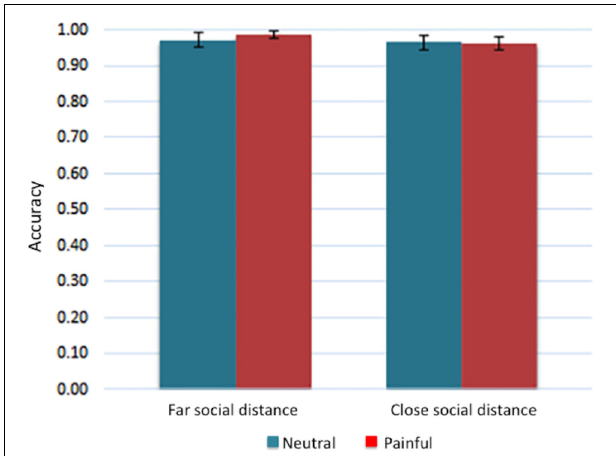
FIGURE 5 | Bar chart displaying mean rating scores for each condition for Experiment 2. Error bars represent standard